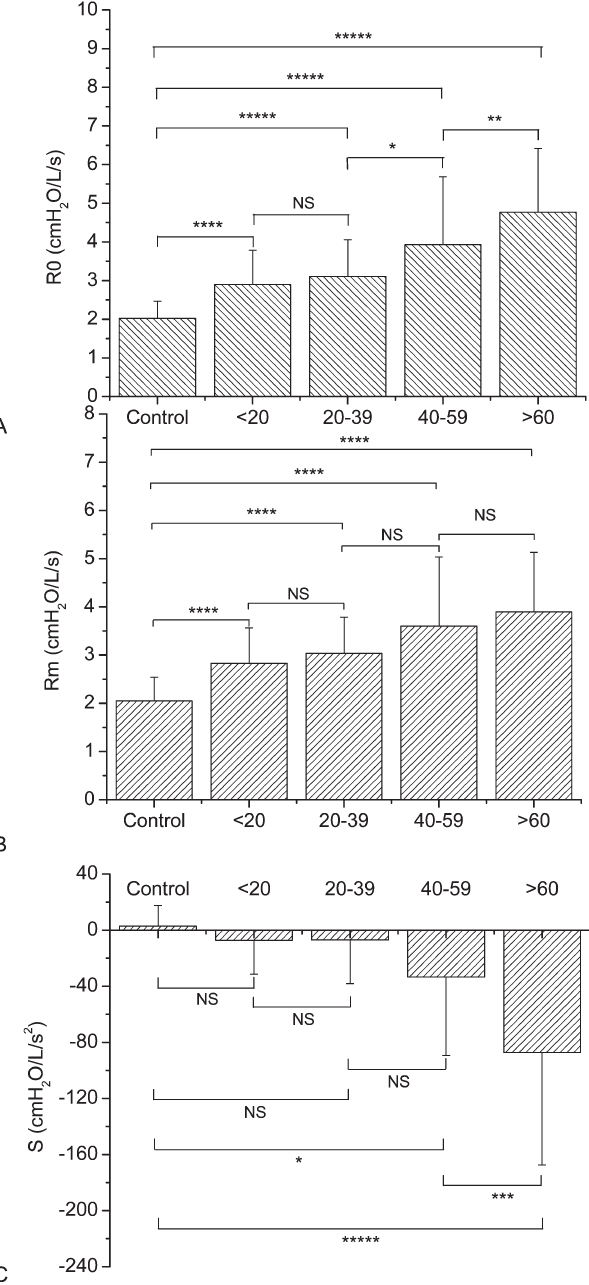
Figure 1 - Effect of the increase in pack-years on resistive parameters. (A) The total respiratory resistance (R0) increases. (B) The mean respiratory resistance (Rm) increases. (C) The slope of the resistive component (S) becomes more